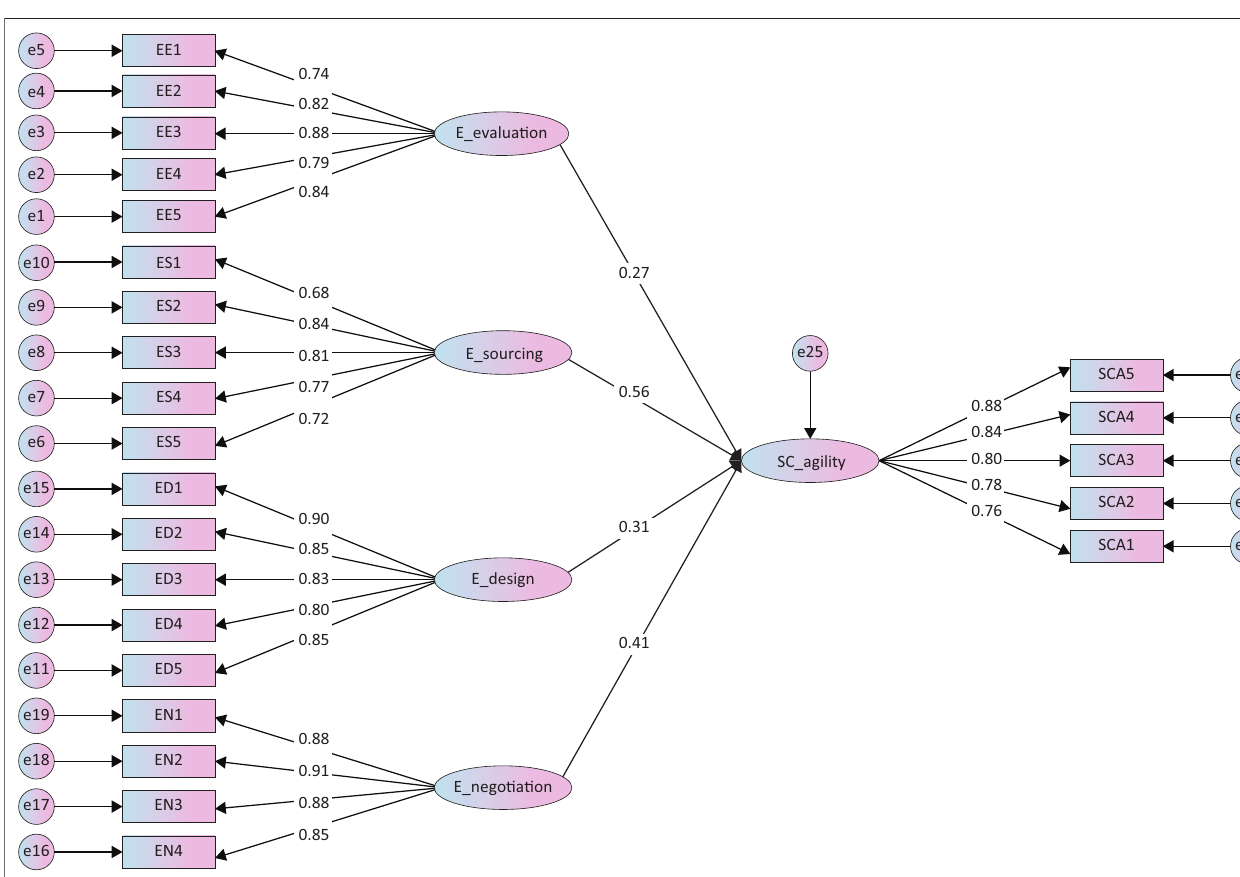
FIGURE 3: The structural model.